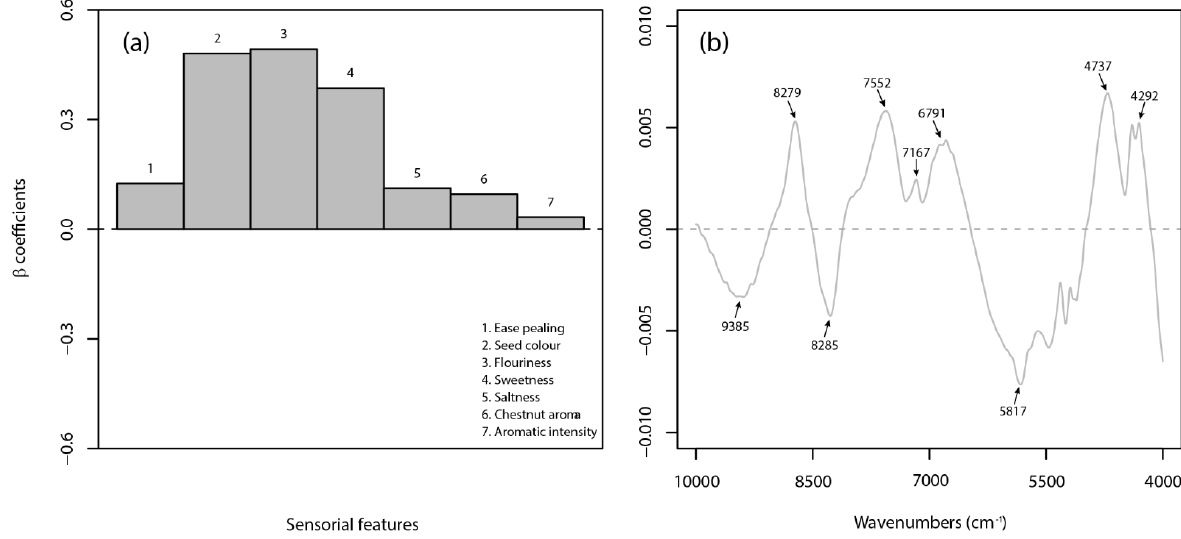
Figure 5. ß-coefficients plots for the best sensory-based ( a ) and spectral-based ( b ) PLS-DA models on boiled chestnuts. All fusion-based PLS-DA models (Fr and Fb) led to impressive classification results, showing clear improvements, with respect to both sensory-based and spectral-based ap- proaches. Bearing in mind the explorative approach of the present study and, thus, that further confirmatory experiments will be required (e.g., model validation with a real ex- ternal dataset), the obtained performance metrics prove to be excellent, consistent, and